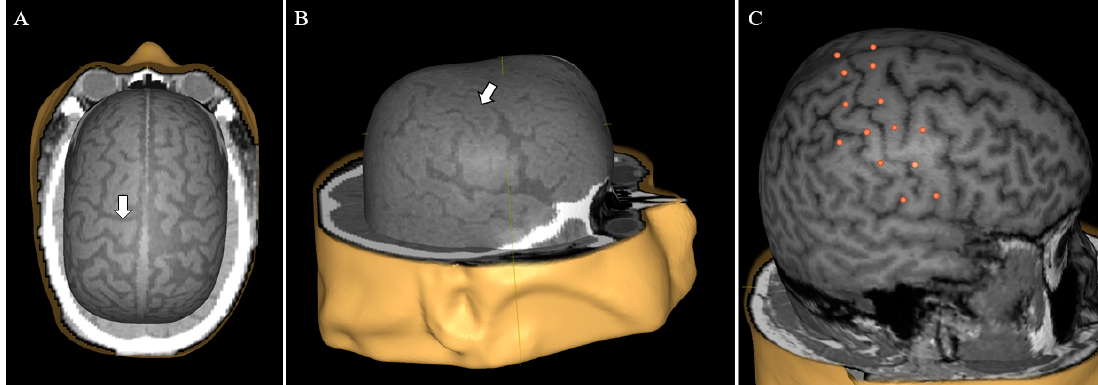
Figure 1. Head model based on computed tomography (CT). By using appropriate preprocessing, CT can serve as a viable basis for head model reconstruction in the nTMS system ( A , B ). Important anatomical structures such as the precentral gyrus are easy to identify ( A , B , white arrows). For image testing, 12 targets were placed around the central sulcus on each hemisphere with two additional targets at the midline vertex (26 targets total per brain, C ).